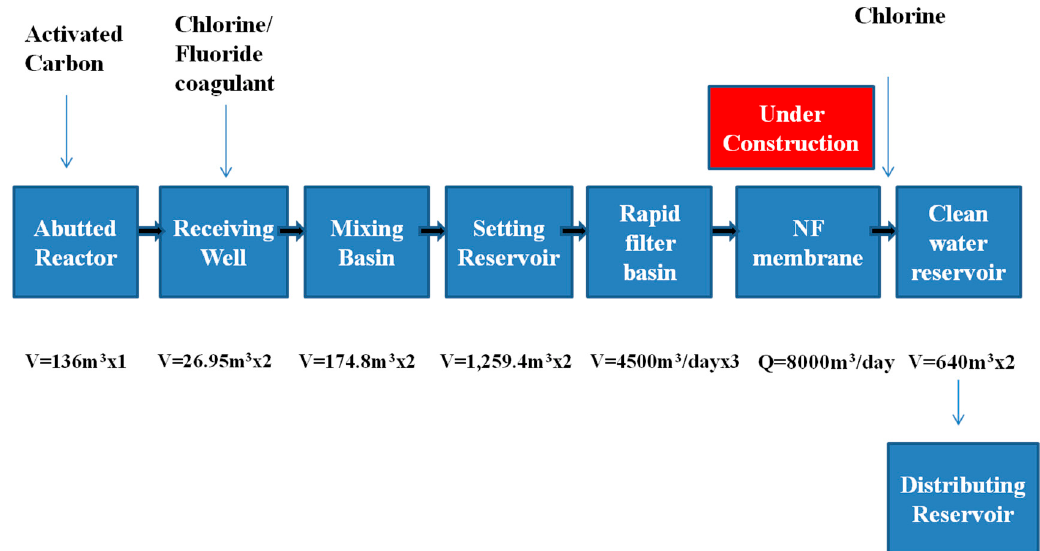
Figure 4. Process and system of TB (2).